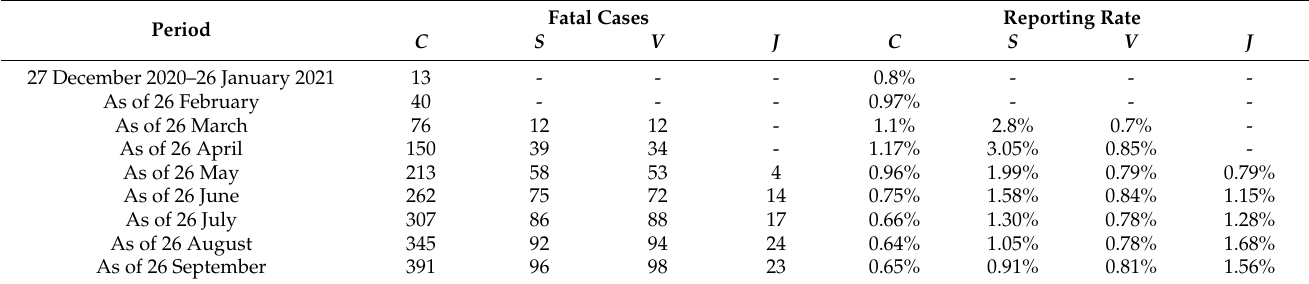
Figure 6. Distribution of reports by onset time of symptoms from vaccination date ( a ), by 1st dose ( b ), and by 2nd dose ( c ). Table 6 lists the numbers of fatal cases by vaccine type, where “ C ” stands for Comirnaty , “ S ” for Spikevax , “ V ” for Vaxzevria , and “ J ” for Janssen . Table 6. Distribution of (unconfirmed) death reports by type of vaccine in Italy (only 16 cases out of the 608 collected by AIFA were officially classified as related to the